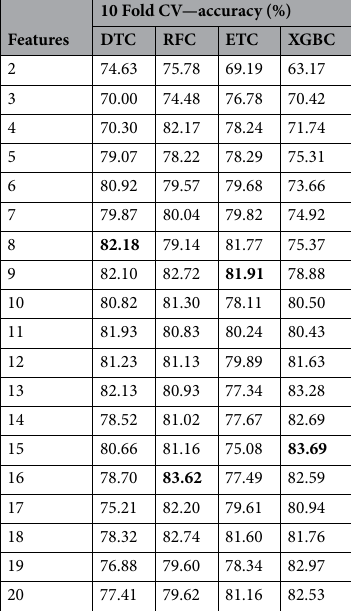
Table 6. Period lengthening dataset, mean accuracy of 10-Fold CV with 100 repetitions. DTC, RFC, ETC, and XGBC trained and tested on feature sets with cardinality between 2 and 20.